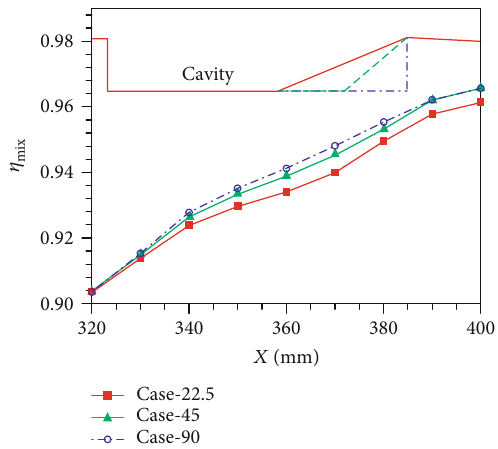
Figure 11: Variation of fuel mixing e ffi ciency around the cavity for all